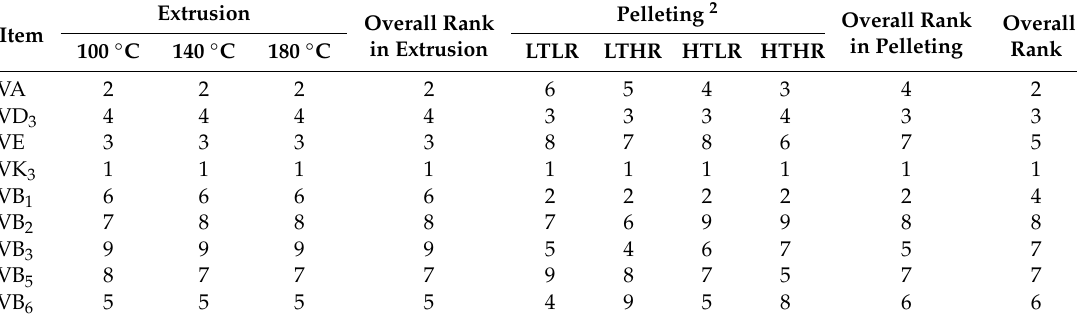
Table 7. Comparison and ranking of activity loss of non-microencapsulated vitamins in extrusion and pelleting 1